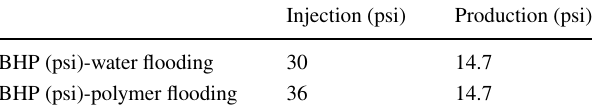
Table 5 Well constrain